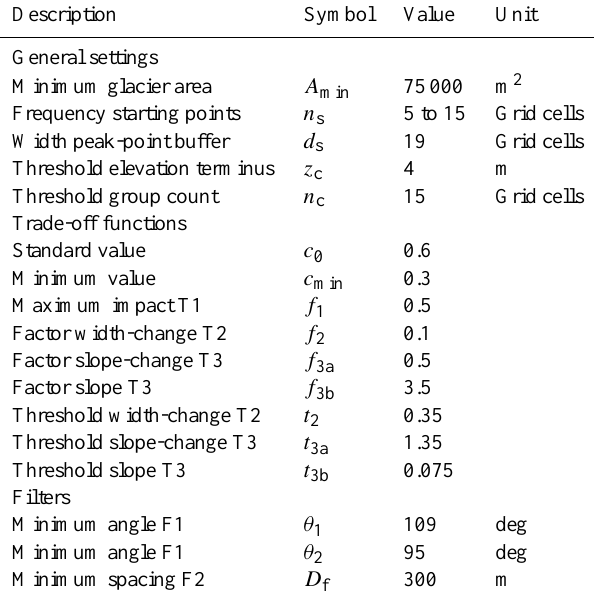
Table A1. Model parameters resulting from the East Greenland cali- bration and applied for the worldwide calculations. Parameters used for Alaska are identical apart from A min = 100000m 2